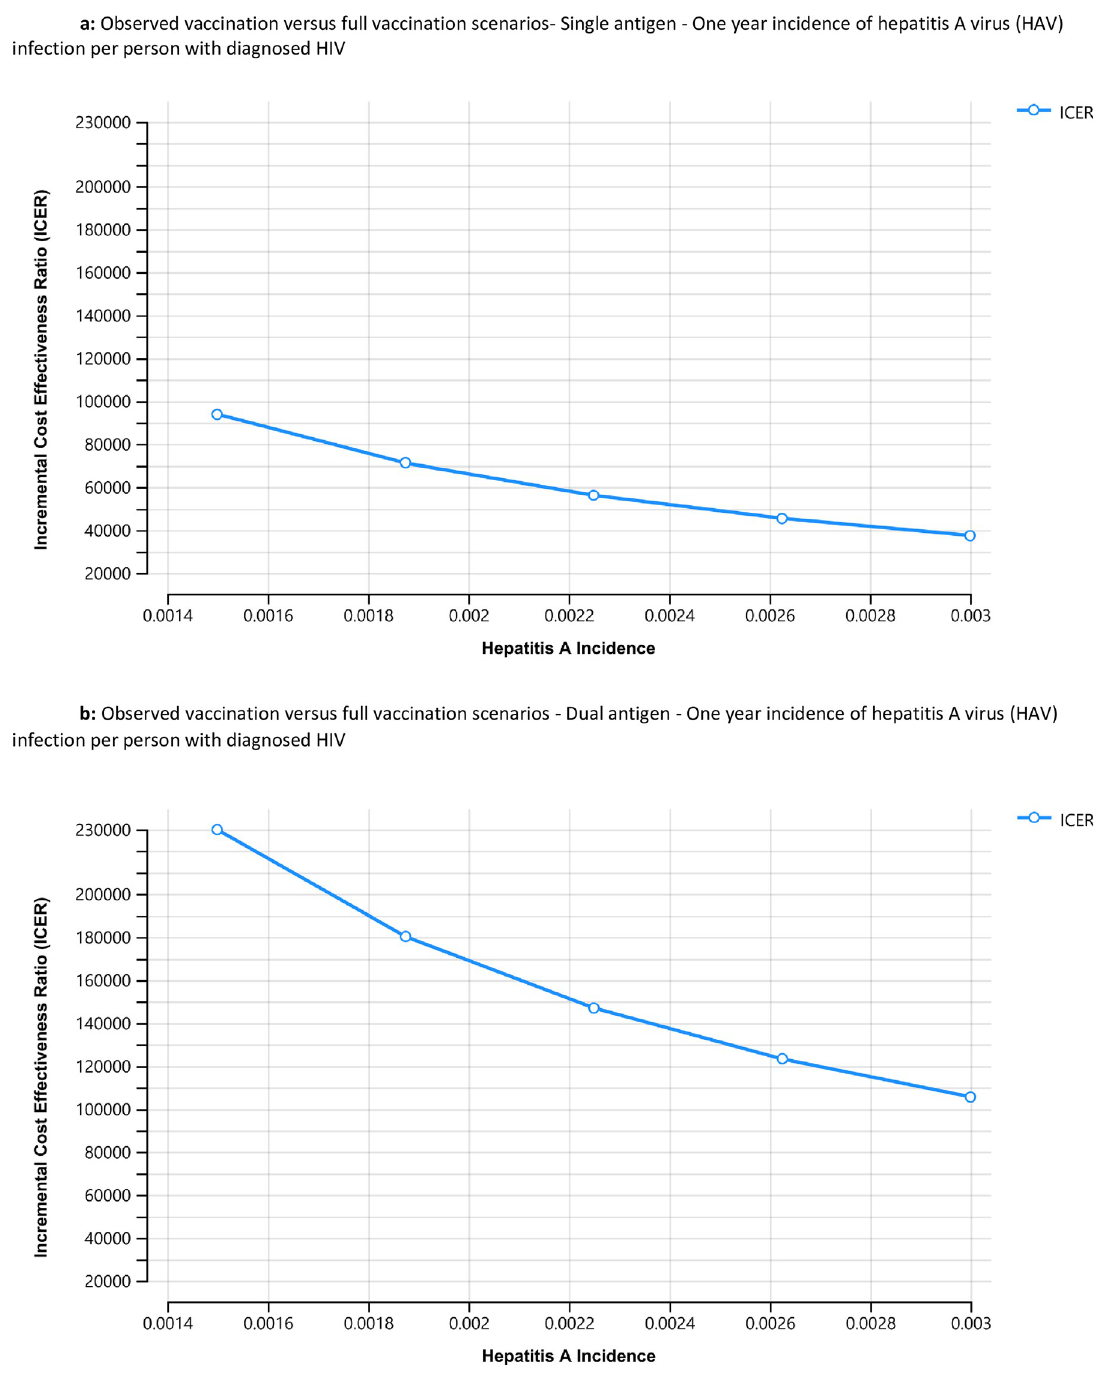
Fig 2. a. Observed vaccination versus full vaccination scenarios—Single antigen—One year incidence of hepatitis A virus (HAV) infection per person with diagnosed HIV. This figure shows sensitivity analysis based on incidence of hepatitis A virus infection comparing observed vaccination with full vaccination for the dual antigen vaccine. The Y axis represents the incremental cost effectiveness ratio (ICER). The X axis represents the range of incidence of hepatitis A between 0.0014 and 0.003. b. Observed vaccination versus full vaccination scenarios—Dual antigen—One year incidence of hepatitis A virus (HAV) infection per person with diagnosed HIV. This figure shows sensitivity analysis based on incidence of hepatitis A virus infection comparing observed vaccination with full vaccination for the dual antigen vaccine. The Y axis represents the incremental cost effectiveness ratio (ICER). The X axis represents the range of incidence of hepatitis A between 0.0014 and 0.003.